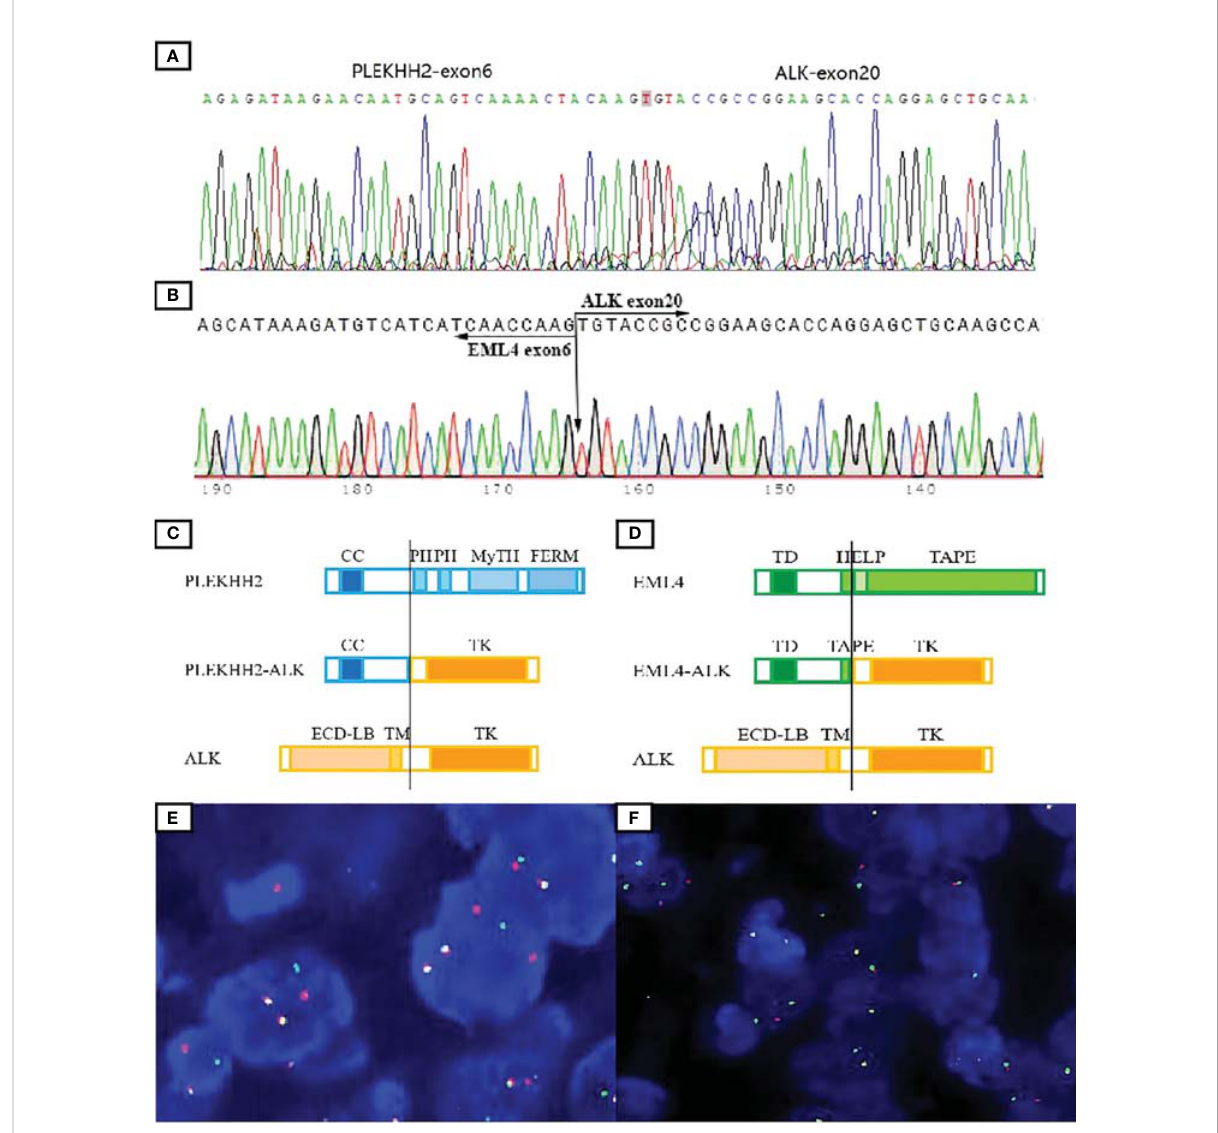
FIGURE 3 Molecular tests to validate ALK fusions. The presence of the PLEKHH2::ALK fusion transcript was validated by Sanger sequencing (A) . Direct sequencing of the puri fi ed RT-PCR products revealed the chimeric transcripts between exon 6 of EML4 and exon 20 of ALK (B) . Schematic representation of the predicted chimeric proteins (C, D) . By ALK break-apart FISH test, most tumor cells in both cases demonstrated a signal pattern consisting of isolated 5 ′ (green) and isolated 3 ′ (orange), along with fused 3 ′ /5 ′ signals (E, F) . TD, trimerization domain; HELP, hydrophobic motif in EML proteins; TAPE, tandem atypical propeller domain; ECD-LB, extracellular ligand-binding domain; TM, transmembrane domain; TK, tyrosine kinase domain; CC, a-helical coiled-coil domain; PH, Pleckstrin homology domain; MyTH, MyTH4 domain; FERM, four- point-one ezrin radxin mesoin